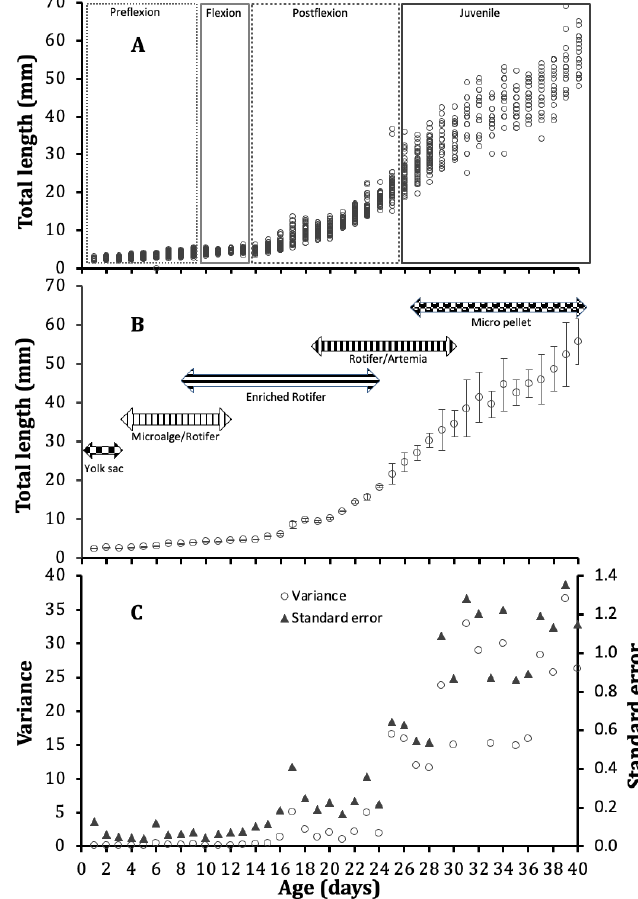
Figure 1. Total length during hatchery production of Totoaba macdonaldi according to age. ( A ) Raw data and development stage, ( B ) Average variation and feeding regime, ( C ) Length variance and standard error-at age.